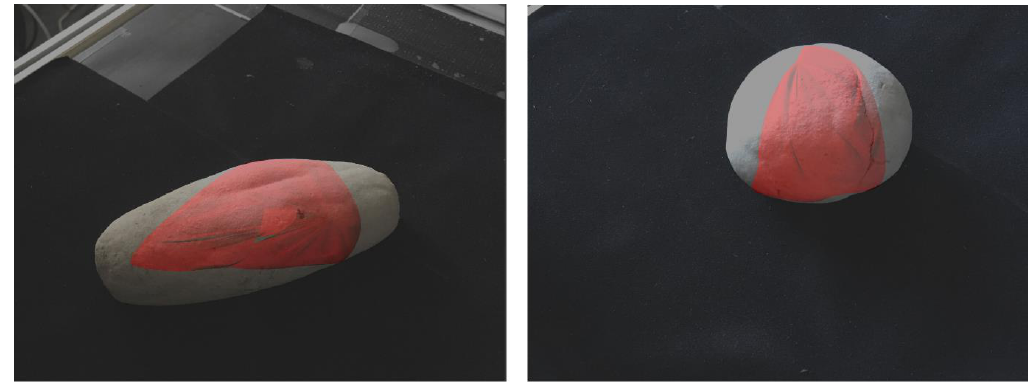
Figure 7. Surface measurement laid over scene images.